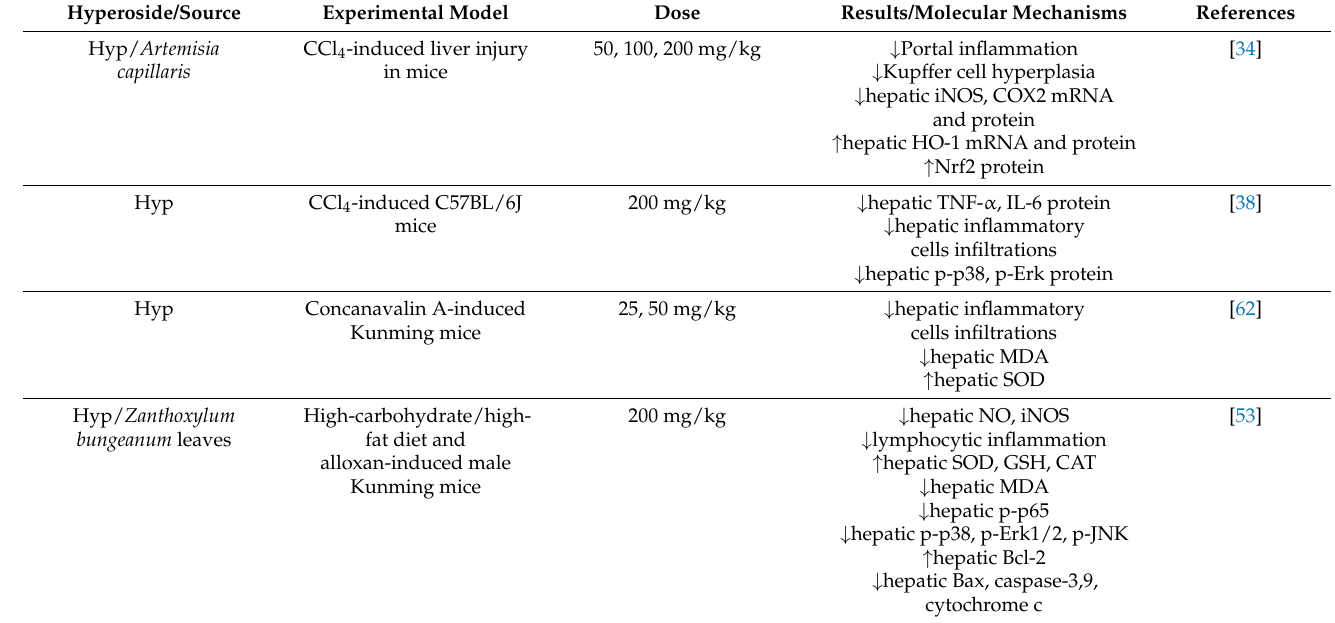
Table 4. Anti-inflammatory activities of hyperoside (Hyp) in experimental models related to hepatic